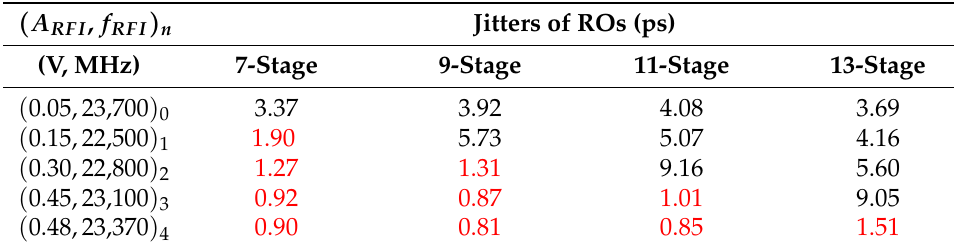
Table 4. Case 1: inverter sizes.